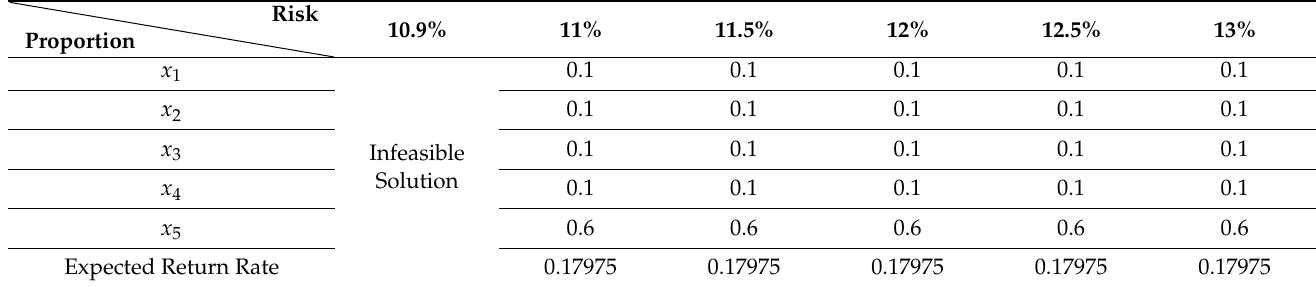
Table 9. The efficient portfolio with s = 3 in a guaranteed return rate (cid:101) p 3 .